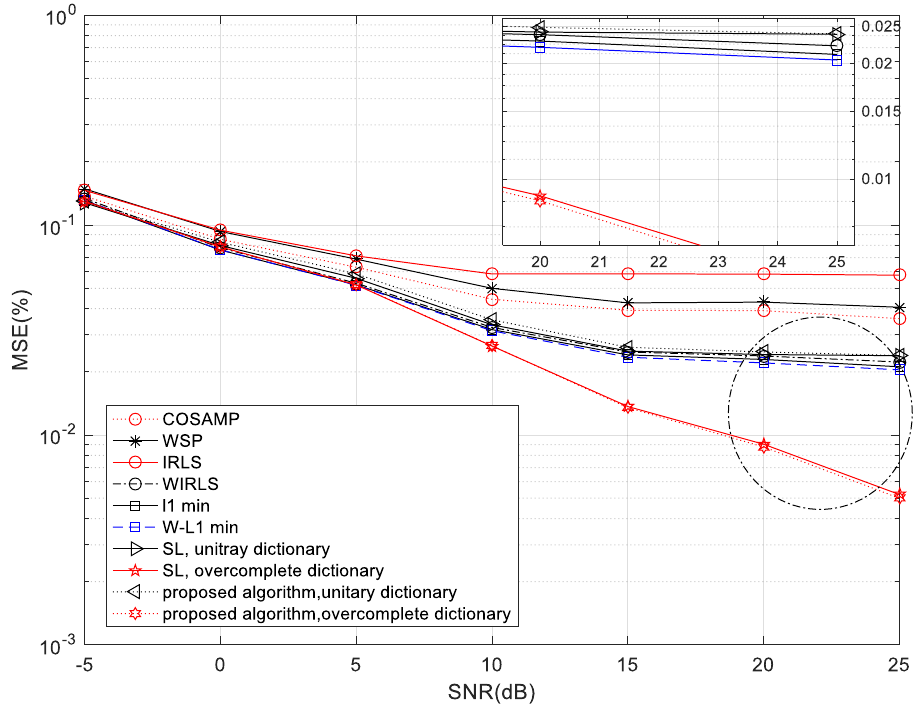
Figure 5. Comparisons of channel estimation mean square error (MSE) for different algorithms.